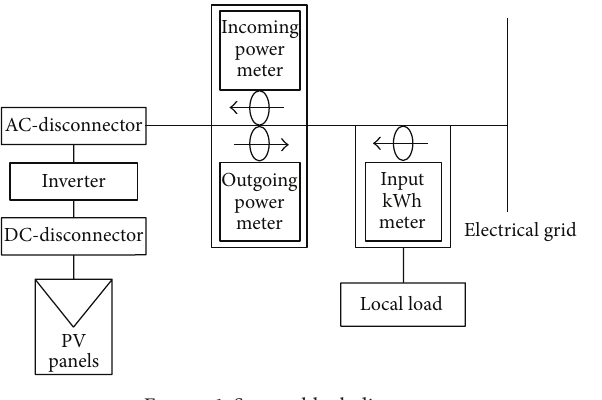
Figure 1: System block diagram.